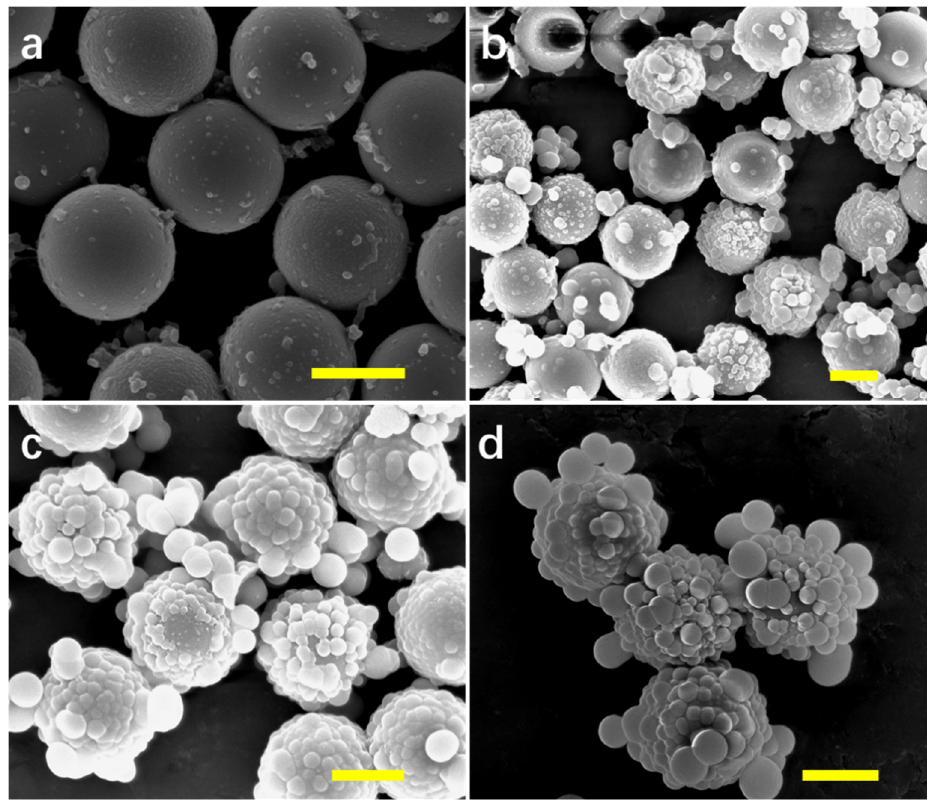
Figure 2. SEM images of PS/SiP composites synthesized with different initial reactant (APTES/L-AA) volume in the system. ( a ) 0.5/5, ( b ) 2/20, ( c ) 3/30, and ( d ) 4/40. Scale bar: 2 µm.